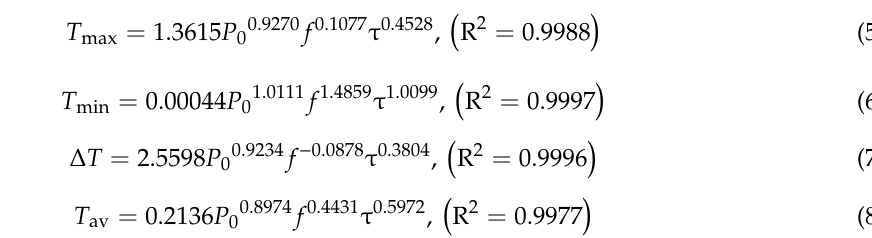
Figure 10. Comparisons between the simulated and the calculated results: ( a ) T max , ( b ) T min , ( c ) ∆ T and ( d ) T av .